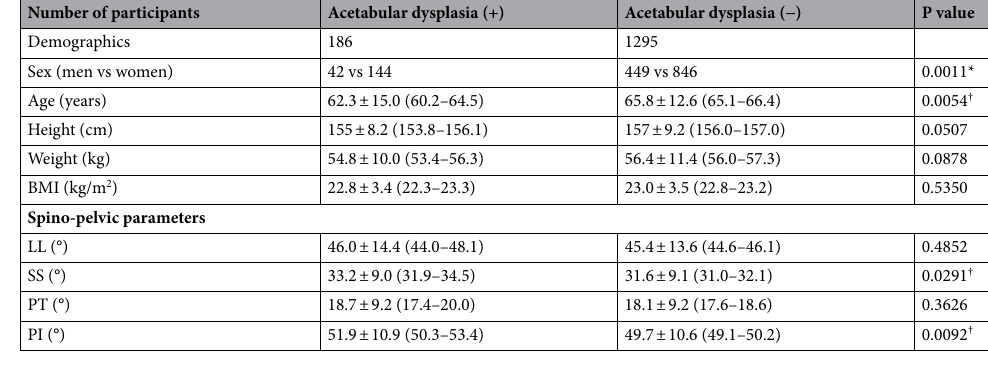
Table 2. Comparison of the demographics and spino-pelvic parameters between the groups with and without acetabular dysplasia. Results are presented as mean ± standard deviation (95% confidence intervals). BMI body mass index, LL lumbar lordosis, SS sacral slope, PT pelvic tilt, PI pelvic incidence. *Significant group difference by chi-square test. † Significant group difference by non-paired t-test.